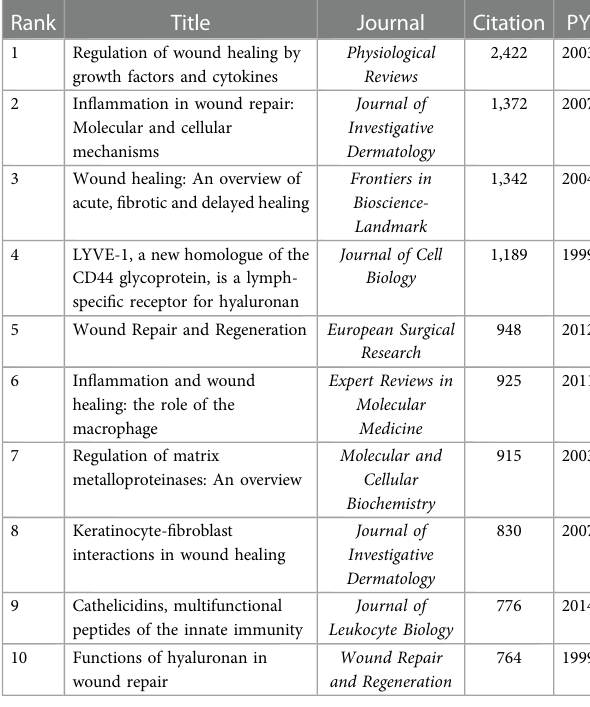
Figure 4 . After reviewing institutions with over 10 published papers, we divided the network of co-authors into fi ve color-coded groups, of which the largest two were green and red. The red group consists of 59 universities focused on The University of Manchester, University of Illinois, and Ohio State University. In both the green and red groups, most cooperative relations are limited to China. For example, the universities in the green group are Chinese.